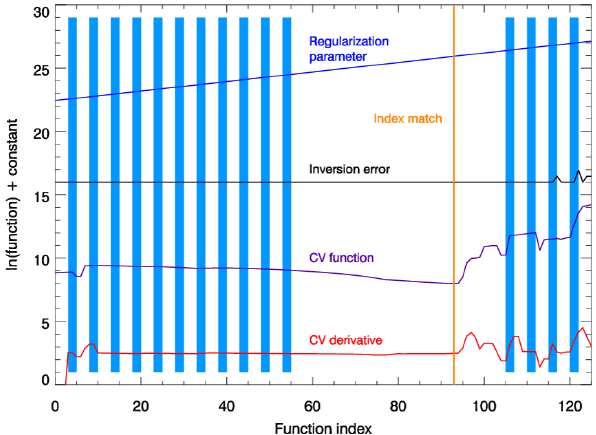
Figure 7. Illustration of the regularized total least squares (RTLS) minimization used for the identification of the optimal regulariza- tion parameter γ r . Shading (with vertical blue lines) of the regions in the range of possible regularization parameters means their rejec- tion from the retrieval, absence of shading means their acceptance. The cross-validation (CV) function (see Eq. 9) is used to locate its minimum and to determine the index of γ r . Alternatively, the peak of the CV derivative occurring where the steepest slope of the CV function occurs can be used to locate the index of γ r . The index of the optimal regularization parameter γ r is marked by an orange